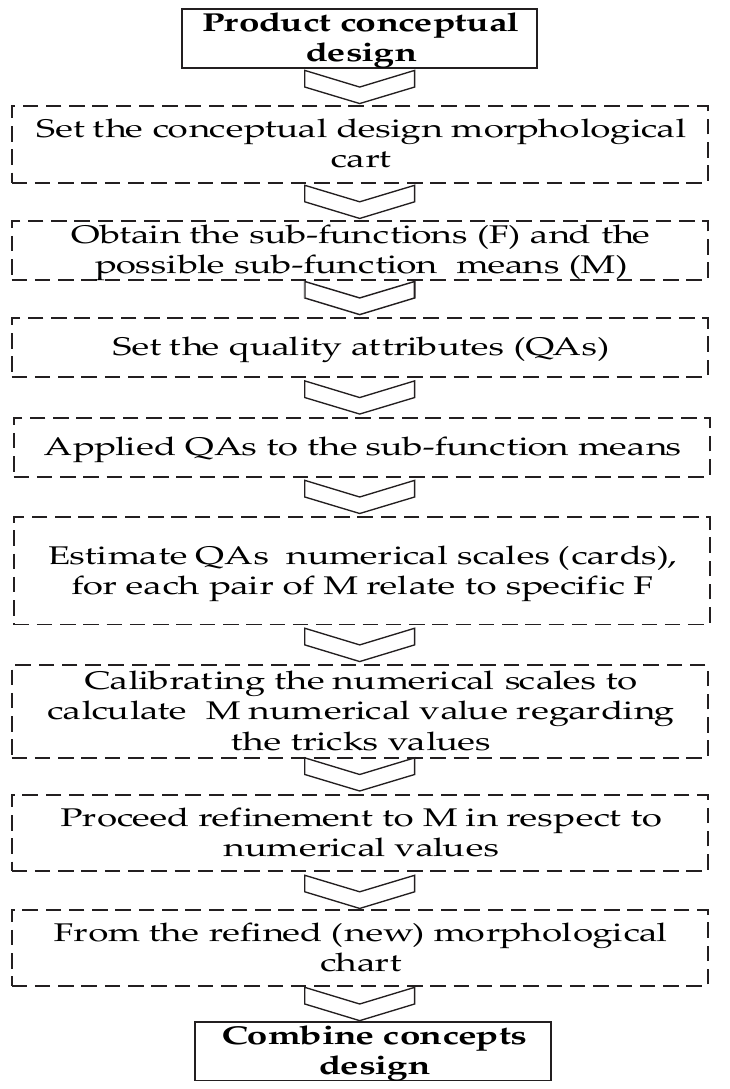
Figure 2. Procedures of the whist game cards calibration strategies ‐ based technique.